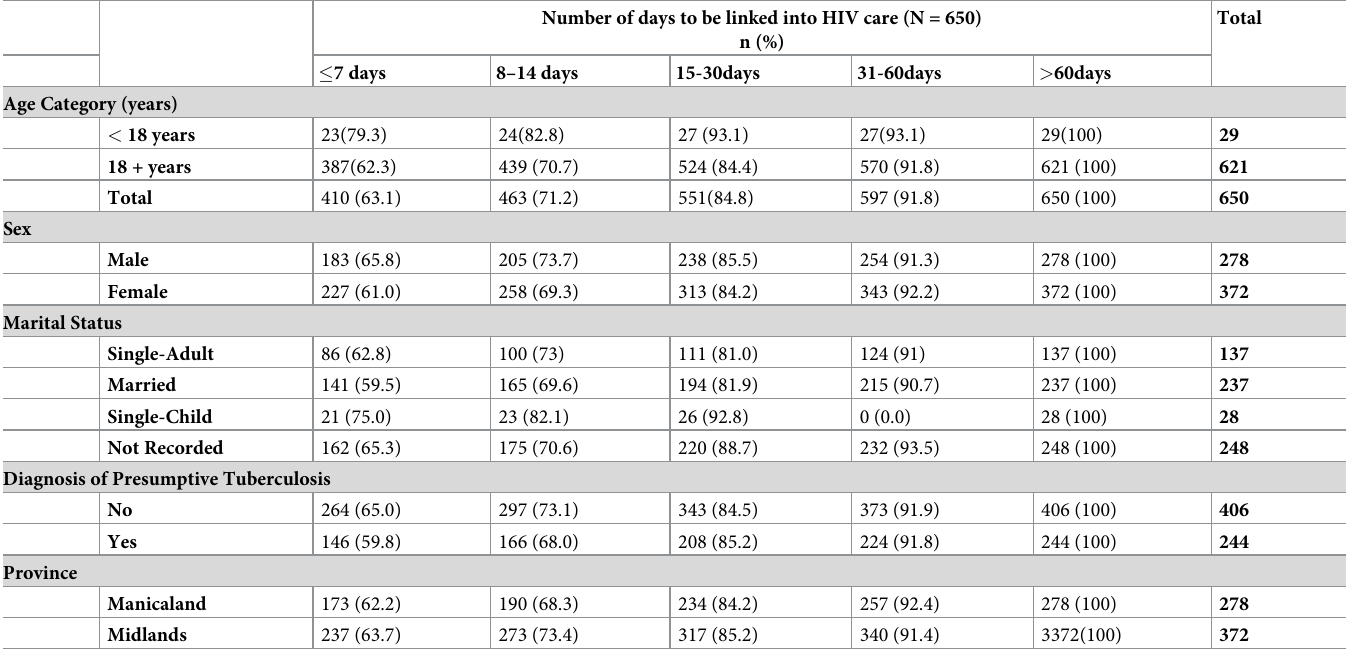
Table 1. Summary of characteristics of clients linked to care.